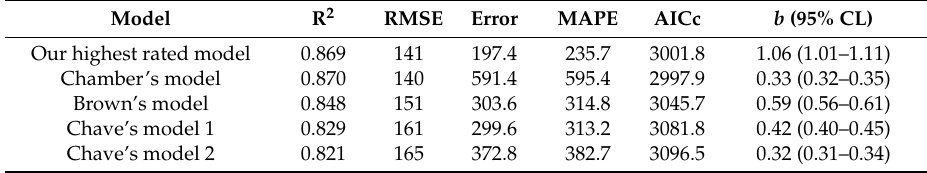
Table 5. Comparison of the predictions of our highest rated model with the generic models using the various goodness of fit criteria and the slope ( b ) of the measured above ground biomass (AGB) with the fitted